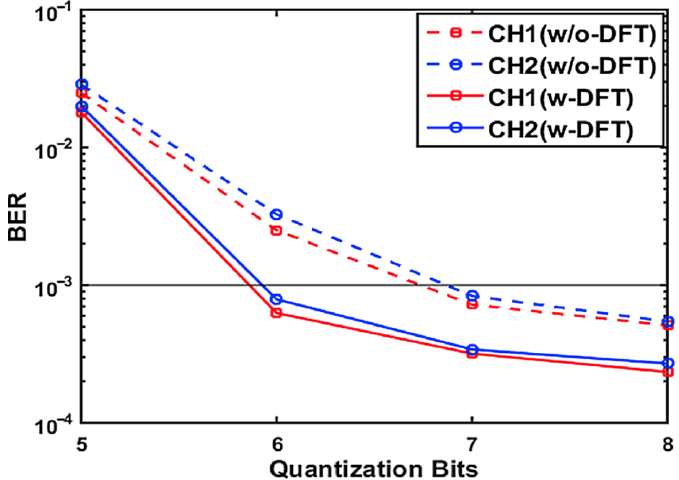
Figure 4. BER versus quantization bits over a 25 km SMMF IMDD PON.